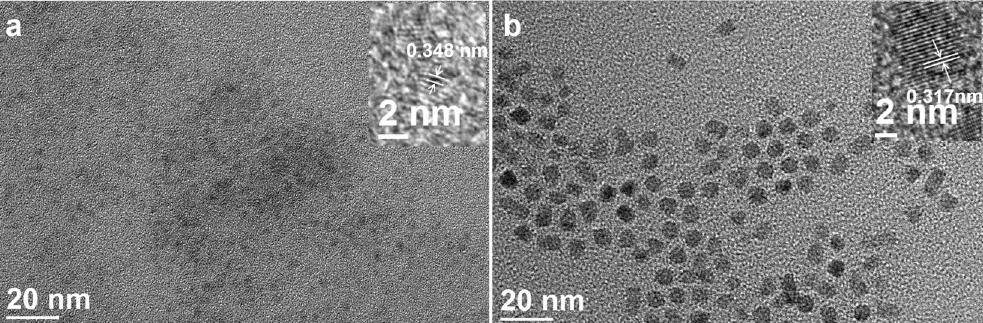
Figure 2. TEM and HRTEM (inset) images of ( a ) bare green-emitting CdSe cores (2.5 nm); ( b ) corresponding green-emitting CdSe/ZnS(7) thick-shell QDs (7.2 ± 0.9 nm), lattice fringes with interlayer distance of 0.348 nm, and 0.317 nm are displayed. The crystallinity is confirmed by the distinct lattice fringes.